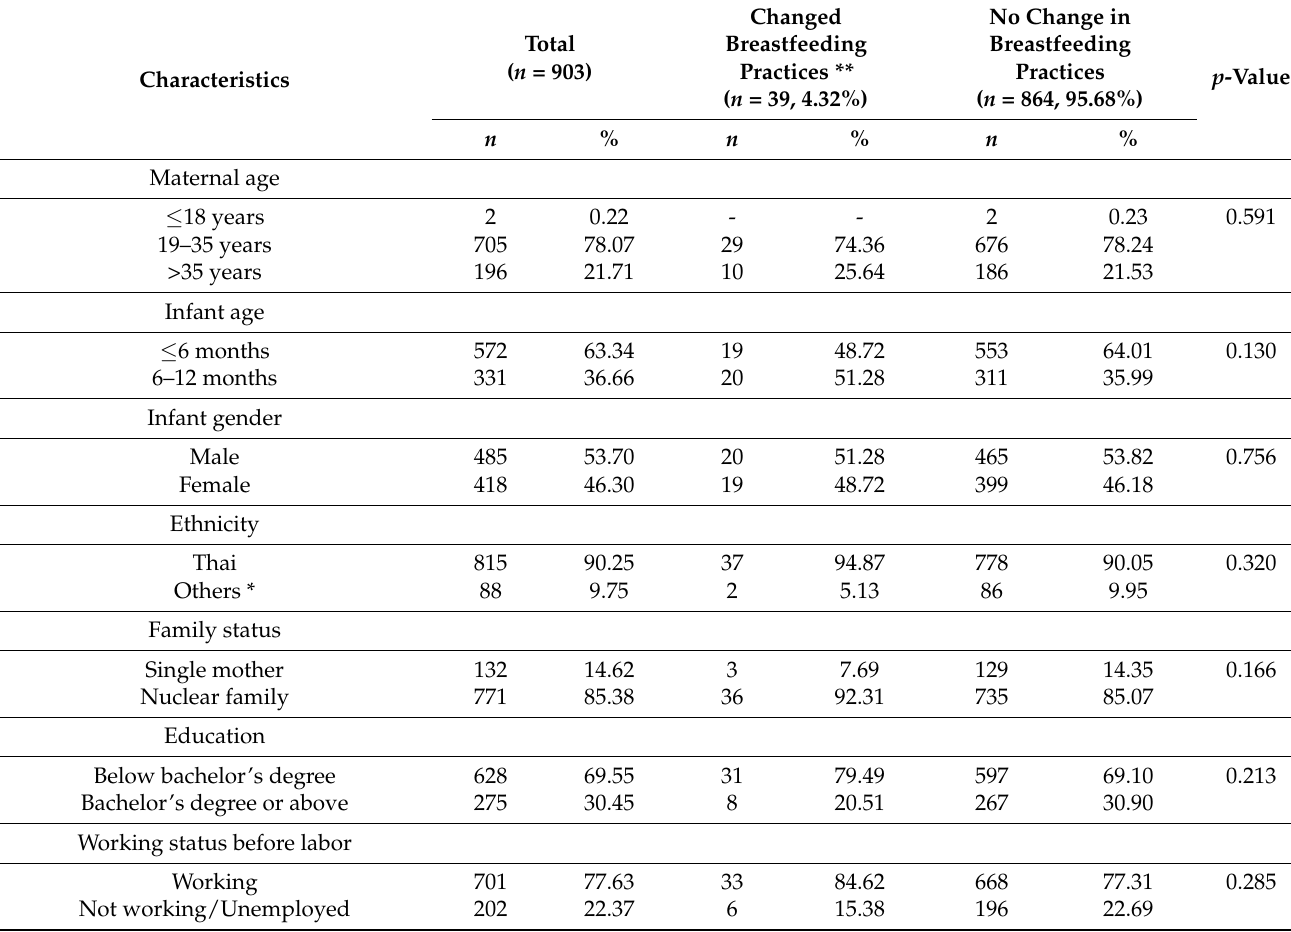
Table 1. Comparison of characteristics between mothers who had changed and not changed breastfeeding practices during the COVID-19 lockdown ( n =